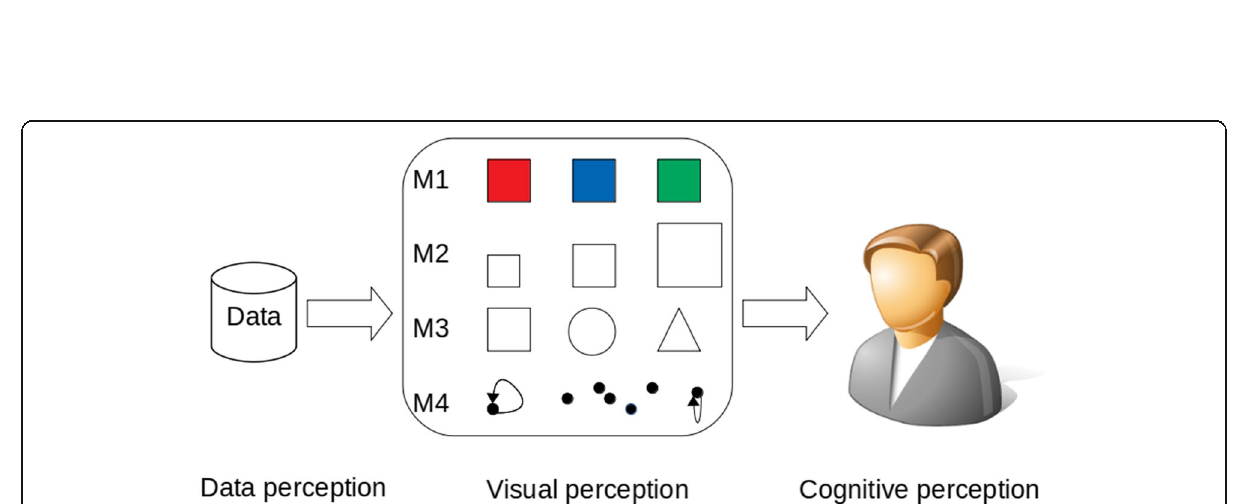
Fig. 2 A visual approach for categorizing misinformation data visualization: M1 (color), M2 (size), M3 (shape), and M4 (spatial